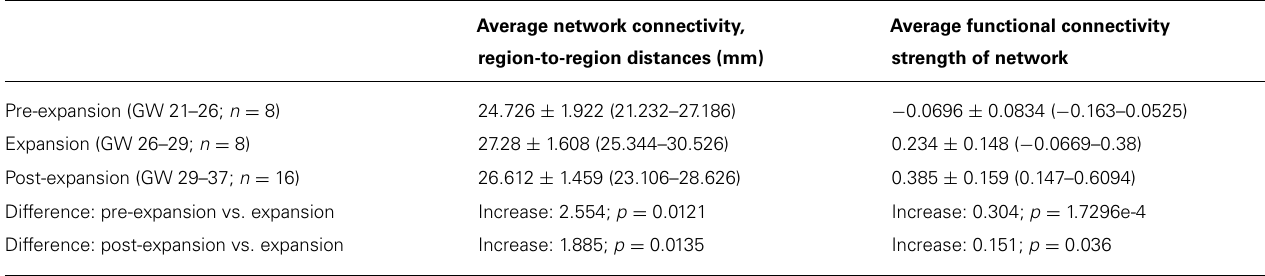
Table 1 | Prenatal development of intrinsic functional connectivity and changes in the region-to-region Euclidean distances. Average network